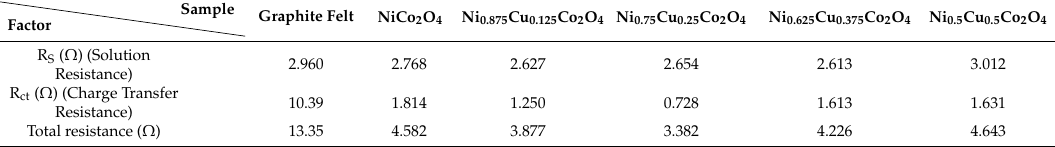
Figure 7. Nyquist plots for all electrodes under an applied potential of 1.7 V. Table 3. Resistance behavior for all electrodes.